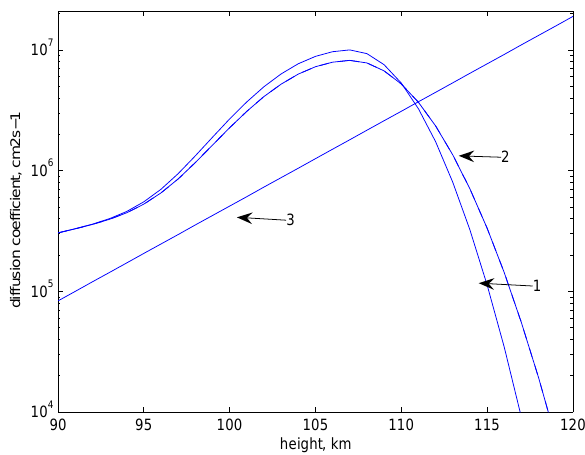
Figure 4. Height profiles of eddy diffusion coefficients corresponding to the observed temperature enhancement (curve 1), the observed disturbances of electron density (curve 2), and the molecular diffusion coefficient (curve 3).